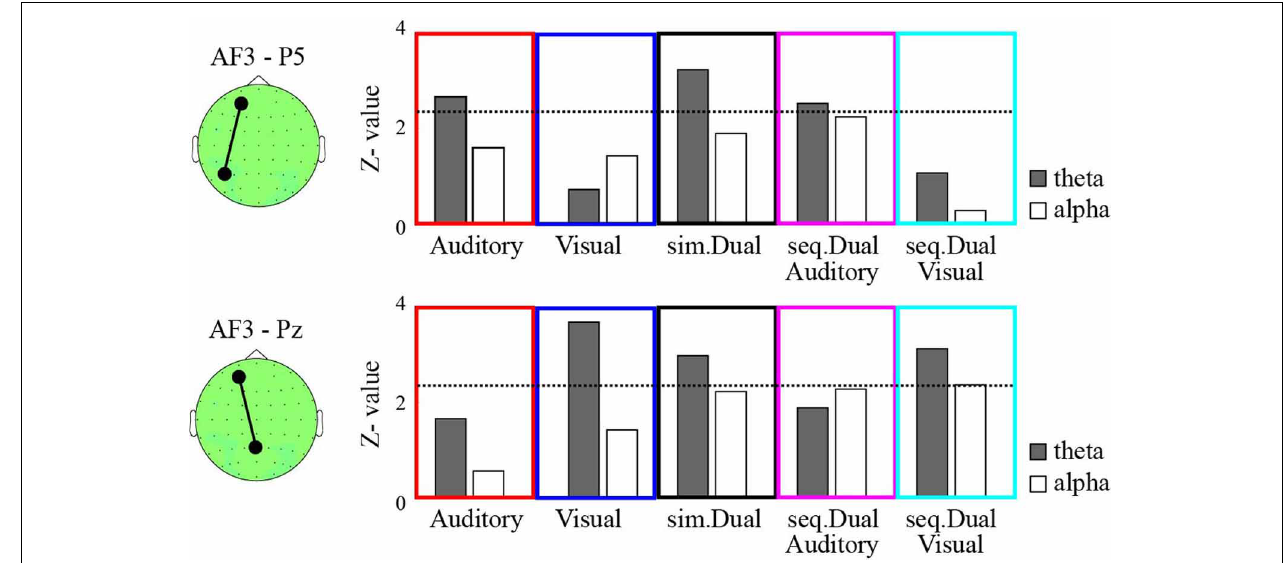
FIGURE 2 | The z -values of the phase synchronization index (PSI) between AF3 and P5 (top) and between AF3 and Pz (bottom) during the manipulation periods compared with the ITI under the auditory-verbal single WM (red), the visual single WM (blue), the simultaneous WM (black), the auditory-verbal manipulation in the sequential WM